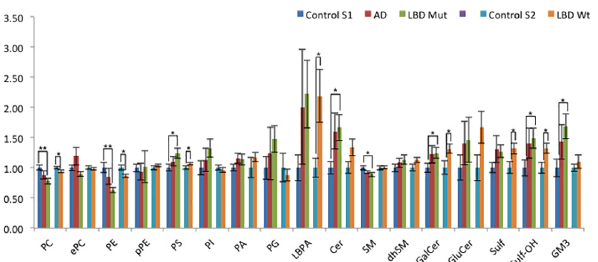
Fig 3. Comparative lipid profile of post-mortem brain tissue obtained from patients diagnosed with various neurological conditions. The individual lipid subclasses of each group of patients was expressed as relative to control group levels for 2 separate sets of experiments ( i . e . AD and LBD GBA mutation carrier relative to Control S1, LBD non carrier (wildtype) relative to Control S2). Statistical analysis for the AD and LBD Mutation samples was based on the one way analysis of variance followed by post hoc Fisher ’ s least significant difference test while the LBD non carrier (wildtype) samples was based on Student ’ s T-test. A false discovery rate control was used to correct for multiple comparisons. * q < 0.05, ** q < 0.01, *** q < 0.001. PC, phosphatidylcholine; ePC, ether phosphatidylcholine; PE, phosphatidylethanolamine; pPE, plasmalogen phosphatidylethanolamine; PS, phosphatidylserine; PI, phosphatidylinositol; PA, phosphatidic acid; PG, phosphatidylglycerol; LBPA, lysobisphosphatidic acid; Cer, ceramide; SM, sphingomyelin; dhSM, dihydrosphingomyelin; GalCer, galactosylceramide; GluCer, glucosylceramide; Sulf, sulfatide; Sulf-h, hydroxylated sulfatide; GM3,